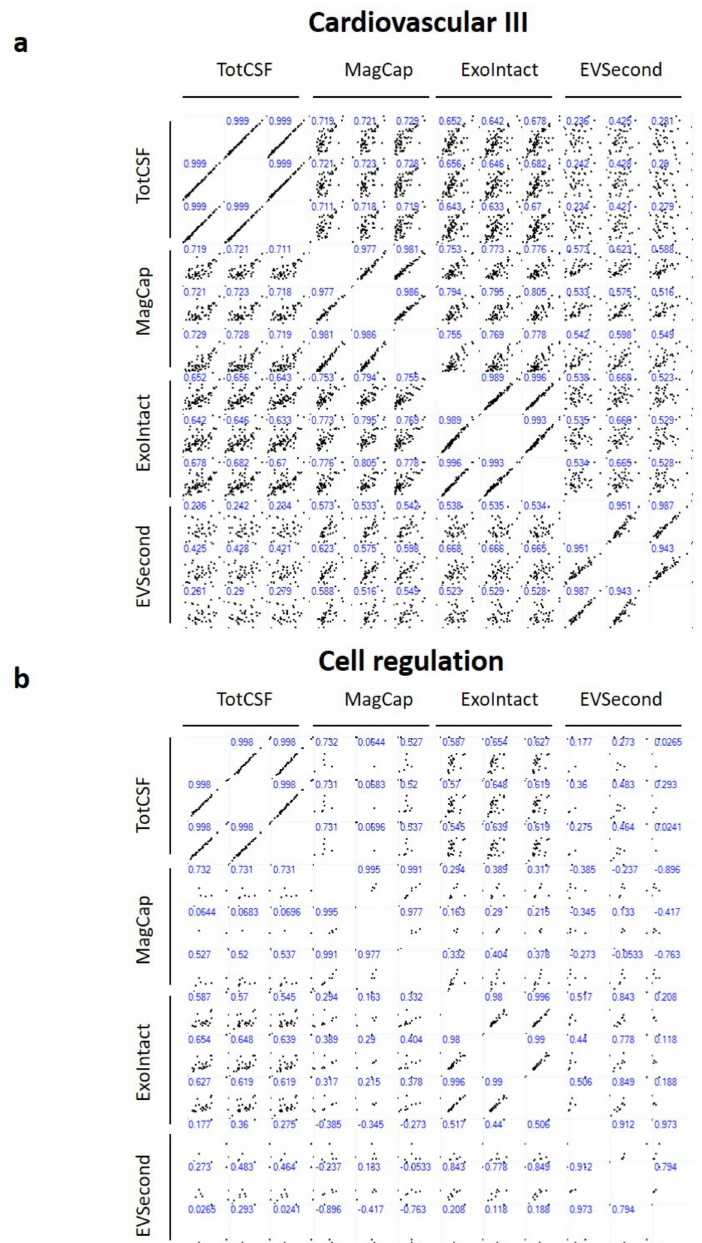
Figure 4. Multiscatter plot of total CSF and EV samples. Values of individual proteins in two samples are plotted for pairwise comparison (the vertical axis is labeled on the left and the horizontal axis is labeled on top). The values in blue represent Pearson’s correlation coe ffi cients for each comparison. Data from the cardiovascular III ( a ) and cell regulation ( b ) panels are shown. Tot CSF: total CSF, MagCap: